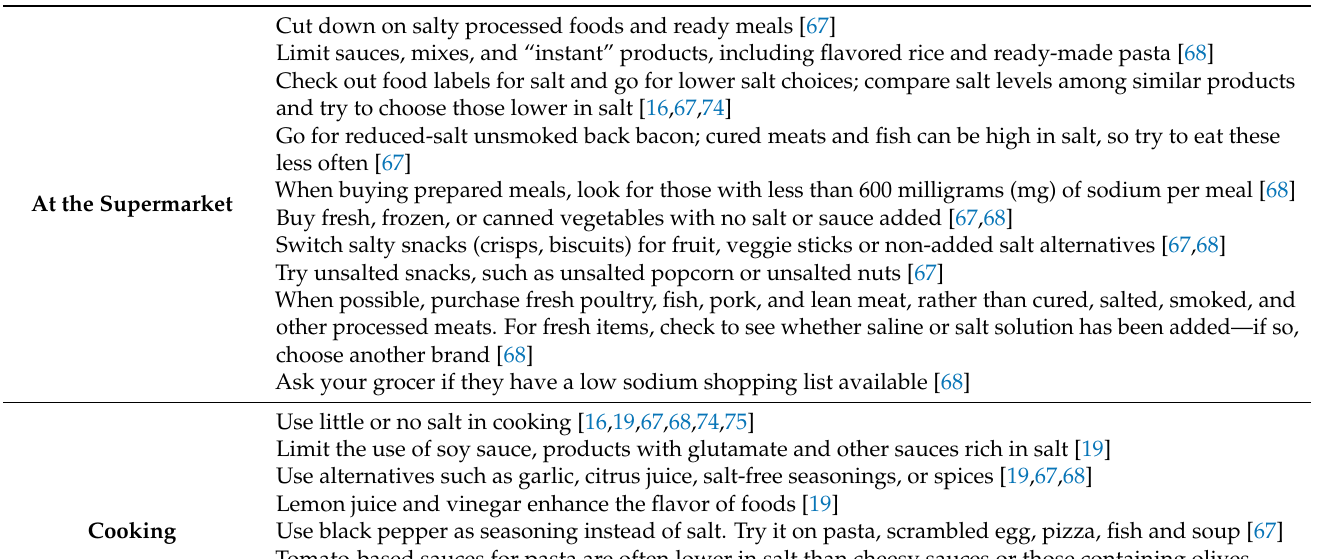
Table 1. Tips for salt reduction according to different national guidelines and the WHO.